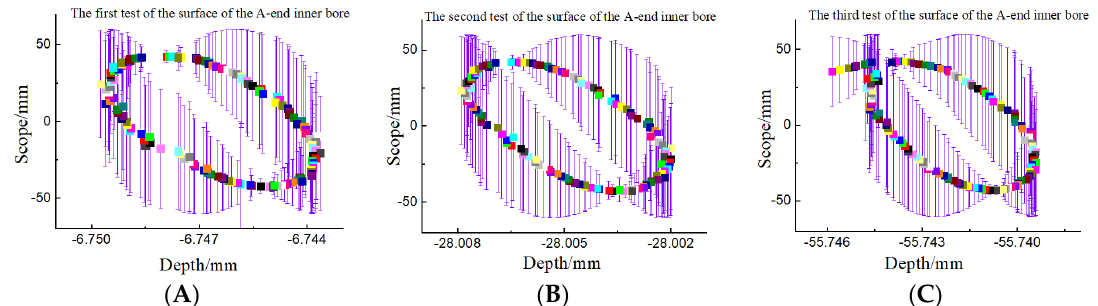
Figure 8. Data diagram of three tests at end A of workpiece. ( A ) First test; ( B ) second test, and ( C ) third